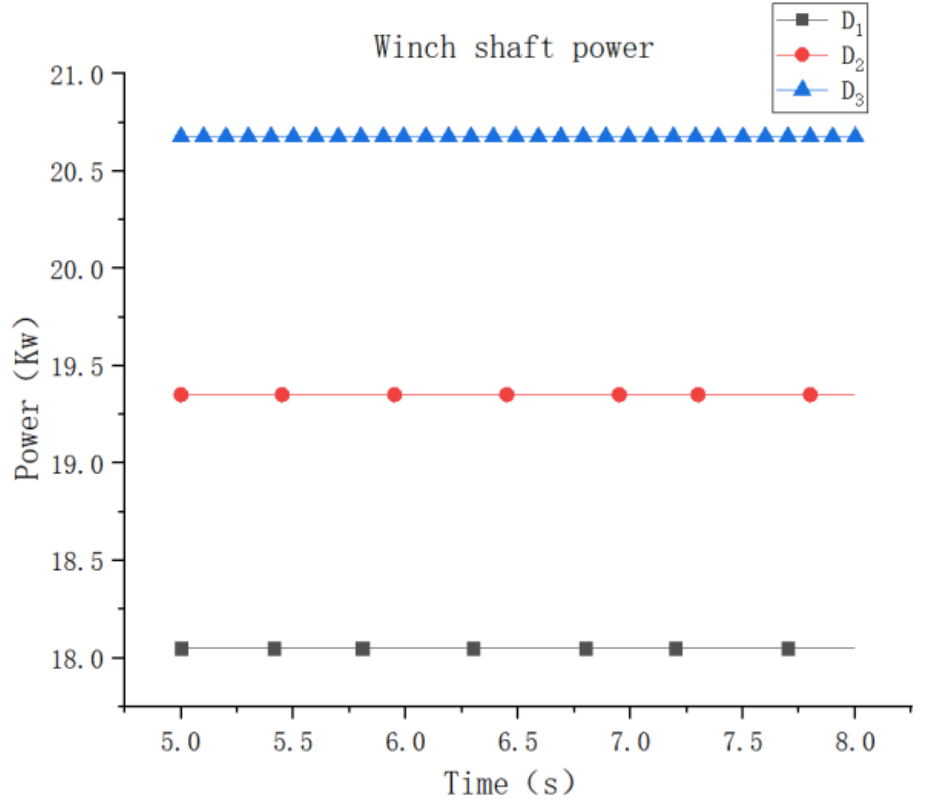
Figure 6. The output power levels of the three groups for different structural parameters of the extrusion parts of the winch shaft.